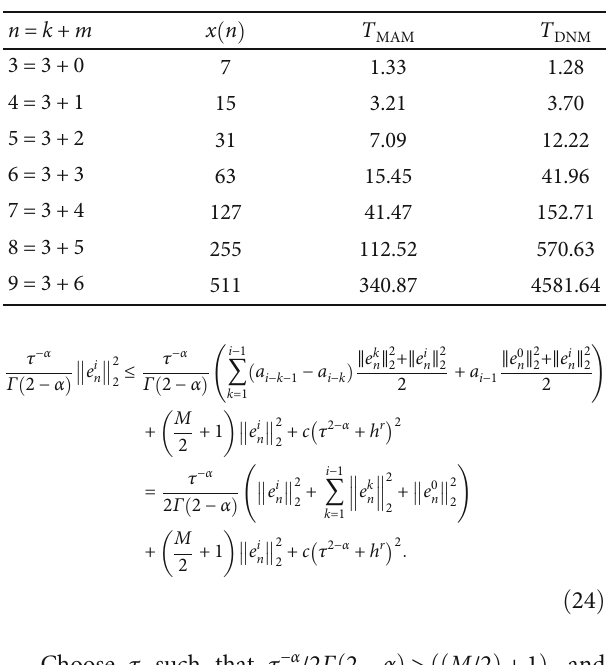
Table 3: Comparison of CPU time between MAM and DNM via linear basis with k = 3, τ = 0 : 001 , and α = 0 : 25 for Example